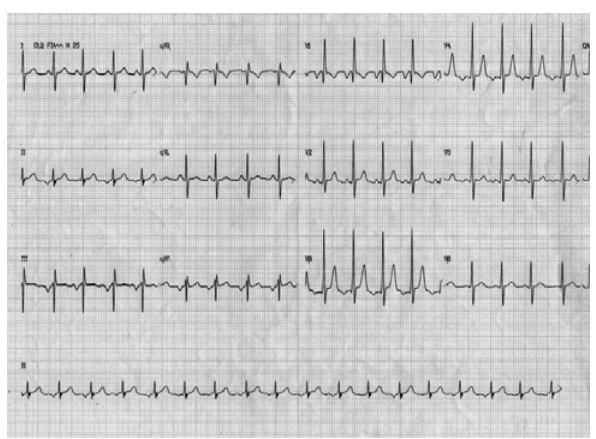
Fig. 1 – Eletrocardiograma